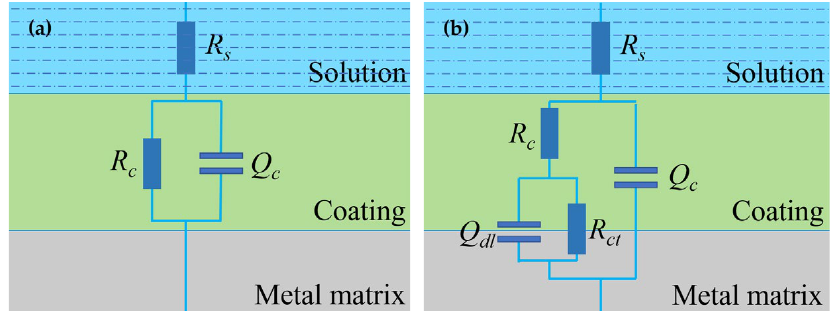
Figure 7. Equivalent circuit models for impedance data fitting. ( a ) Model A, ( b ) Model B. Table 2. The impedance fitting parameters of the FW-1 coating sample.